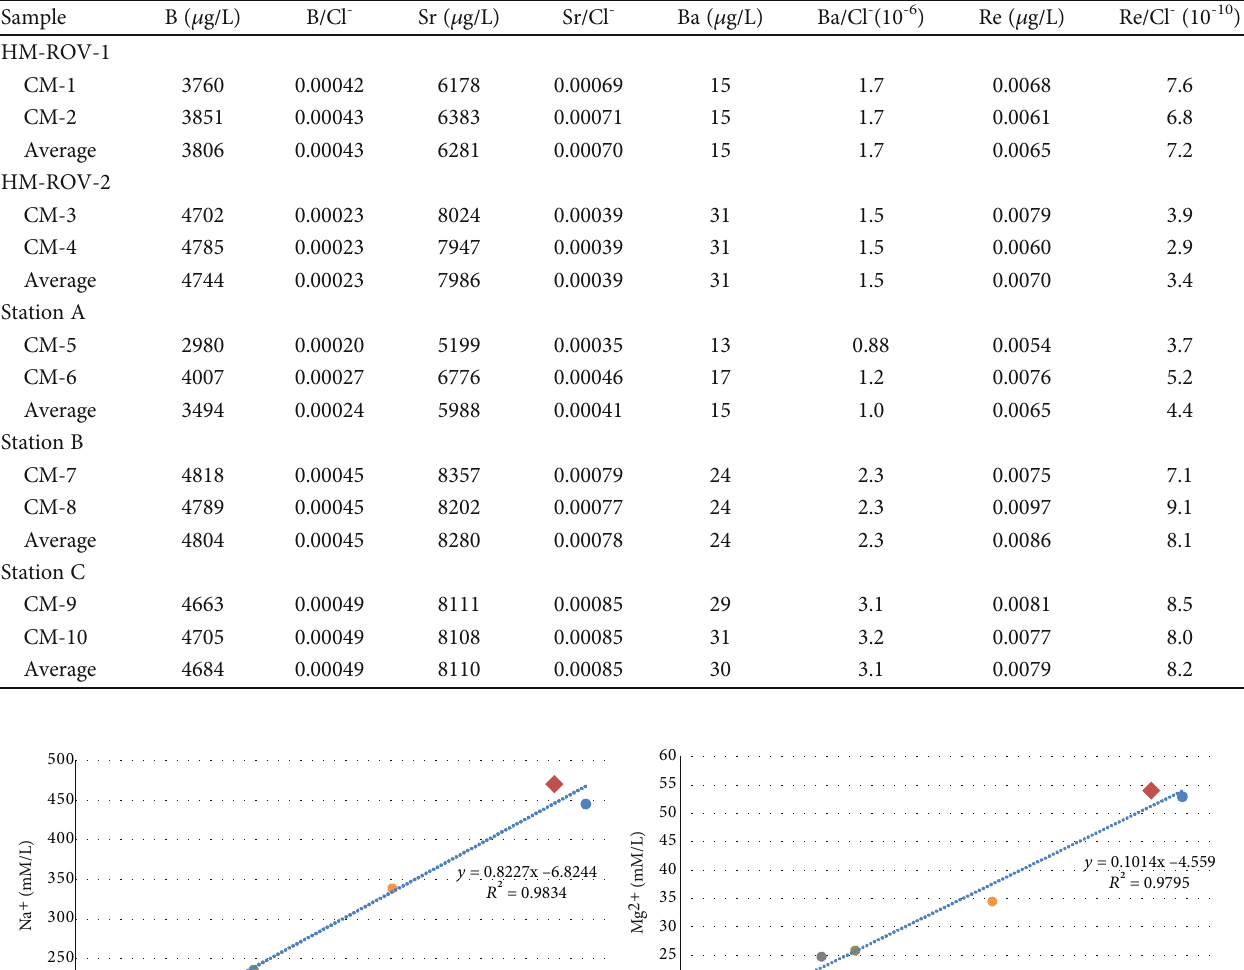
Table 2: Concentrations of B, Sr, Ba, and Re and ratios B/Cl - , Sr/Cl - , and Re/Cl - .